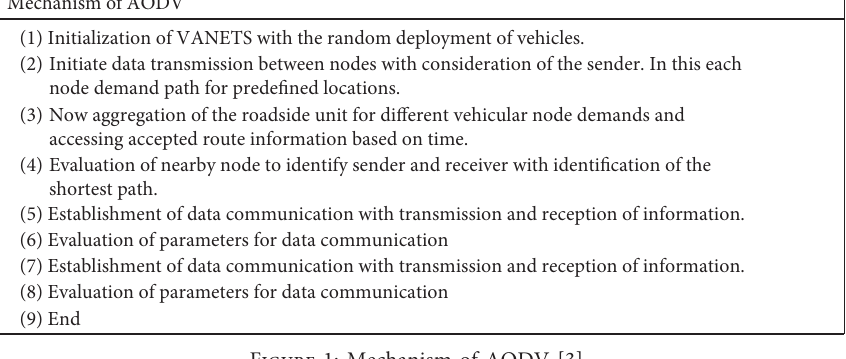
Figure 1: Mechanism of AODV [3].